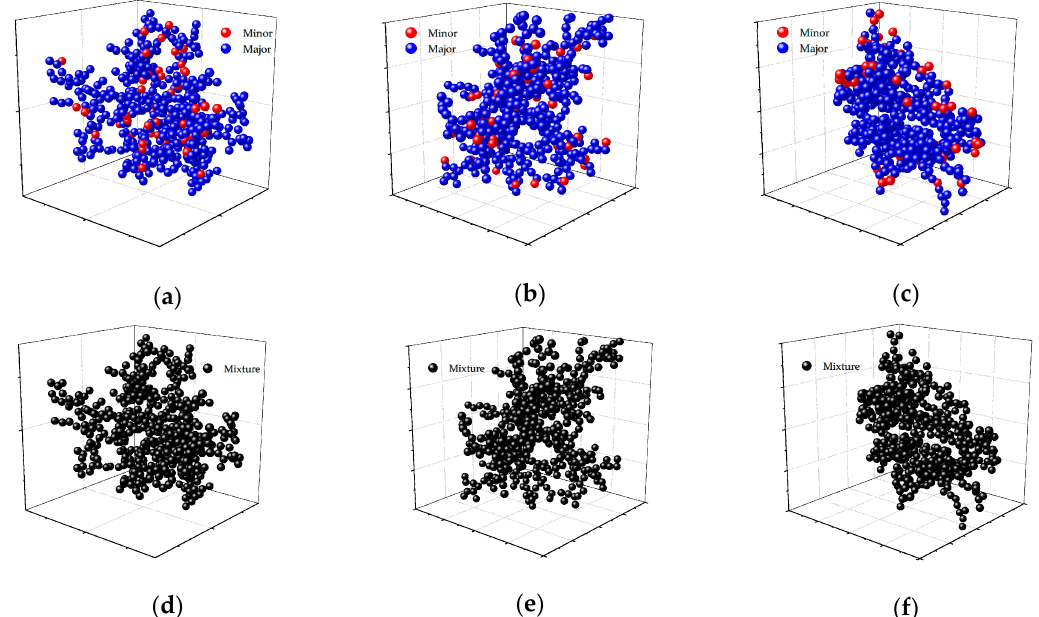
Figure 1. Particle aggregates composed by spatially randomly distributed spherical particles of uniform size. Mode A: chemical component concentrated in a few particles; Mode B: chemical components evenly distributed in each particle. ( a ) and ( d ) are of the same structure, as are ( b ) and ( e ) as well as ( c ) and ( f ).